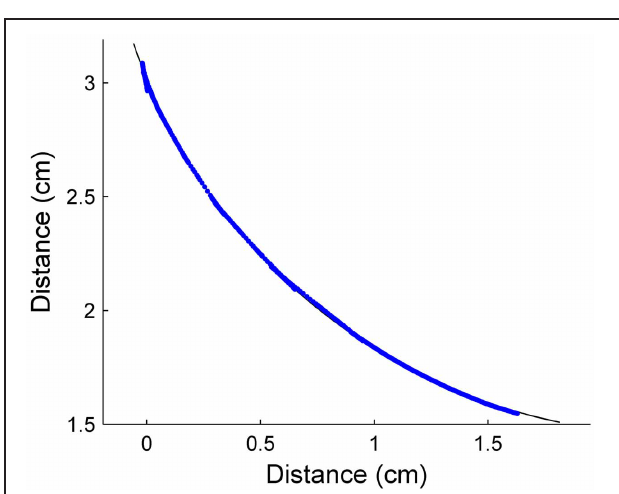
FIGURE 8 | Radial distance estimation, in hardware, using a translational sweeping algorithm to calculate radial distance. Contour extraction was performed as a 2.5cm diameter cylinder was translated past a single whisker. The estimated data points (blue) are plotted over a solid line (black) indicating the actual profile of the cylinder. The maximum difference between actual object position and the estimated contact point was 0.1mm.